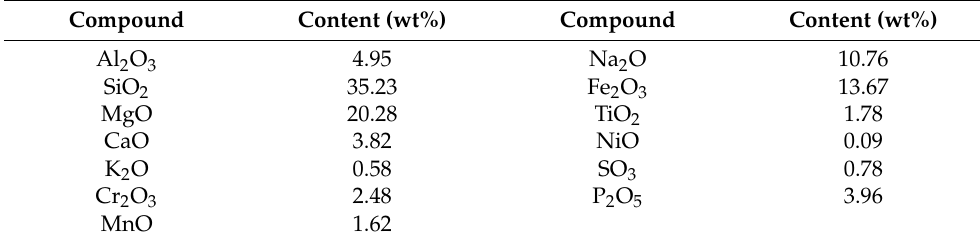
Table 1. Chemical composition of roasted slag, measured by XRF.